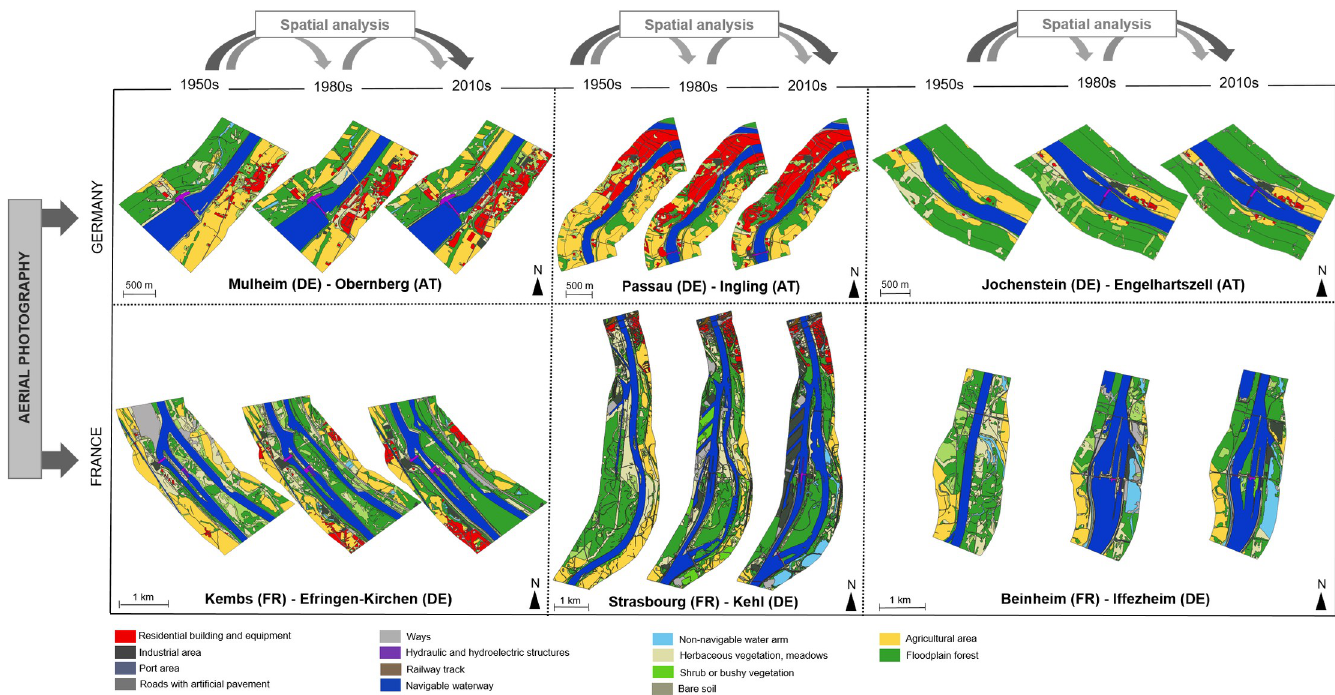
Fig 2. Methodological approach with digitalizations of all six sites based on typology for the three reference dates (1950, 1980 and 2010).